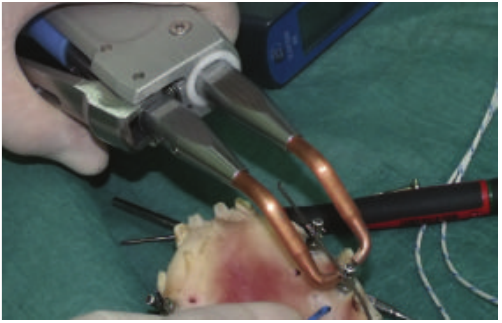
Figure 5: The resistance spot welding